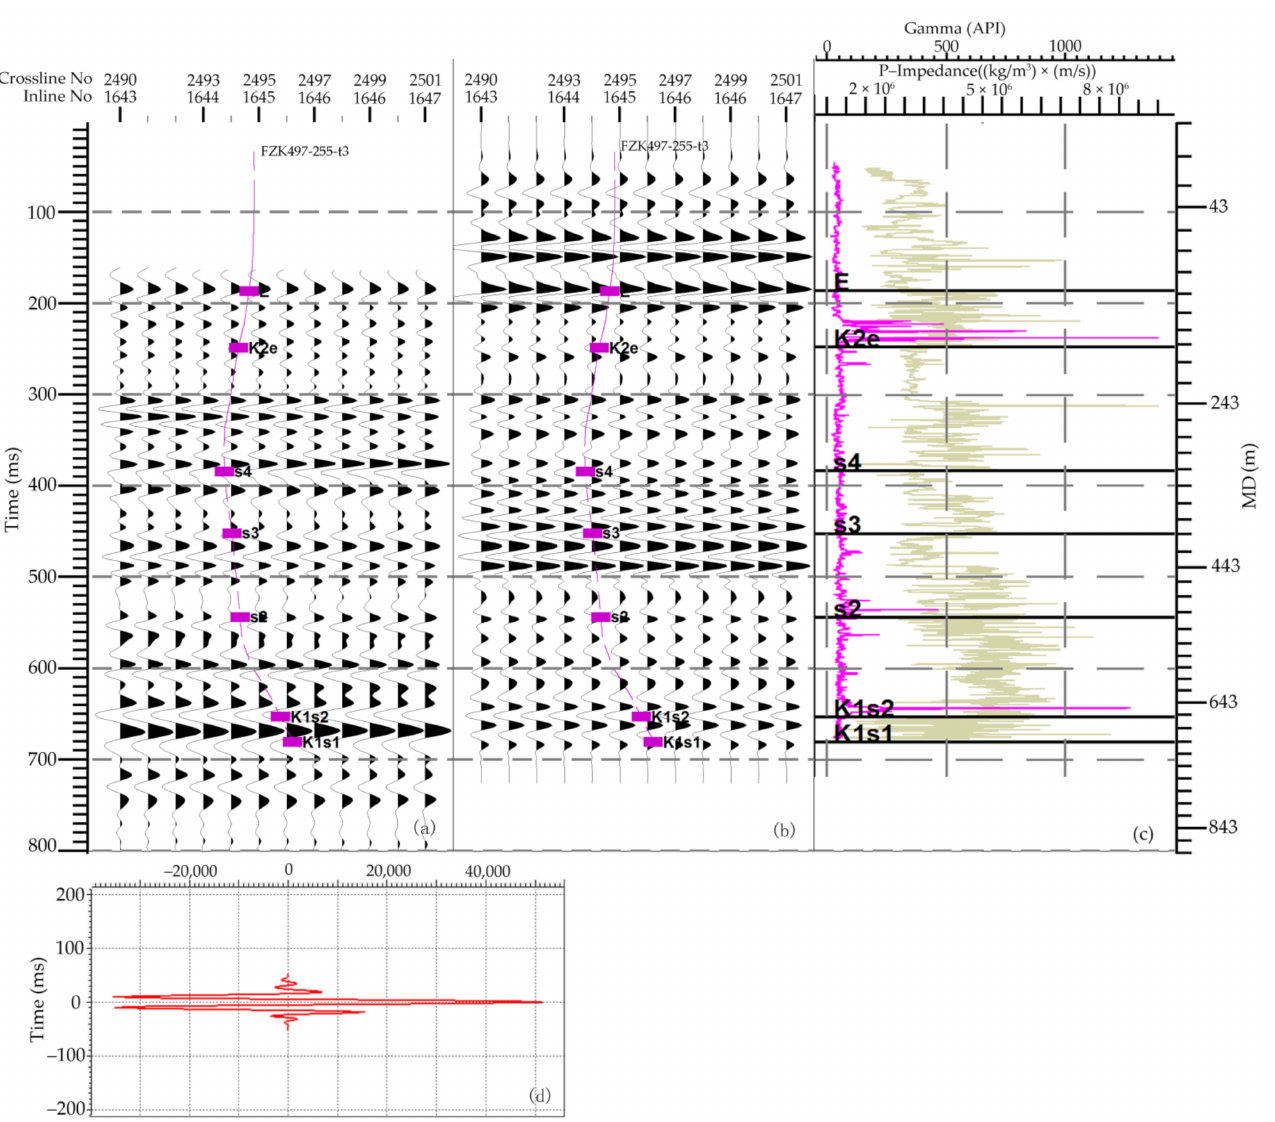
Figure 3. Synthetic seismic calibration of the typical borehole data from the 3D seismic study area. ( a ) the seismic data; ( b ) synthetic model calculated by the convolution of the reflection coefficient and the wavelet; ( c ) the gamma and impedance loggings of the typical well; ( d ) the wavelet extracted from well and seismic